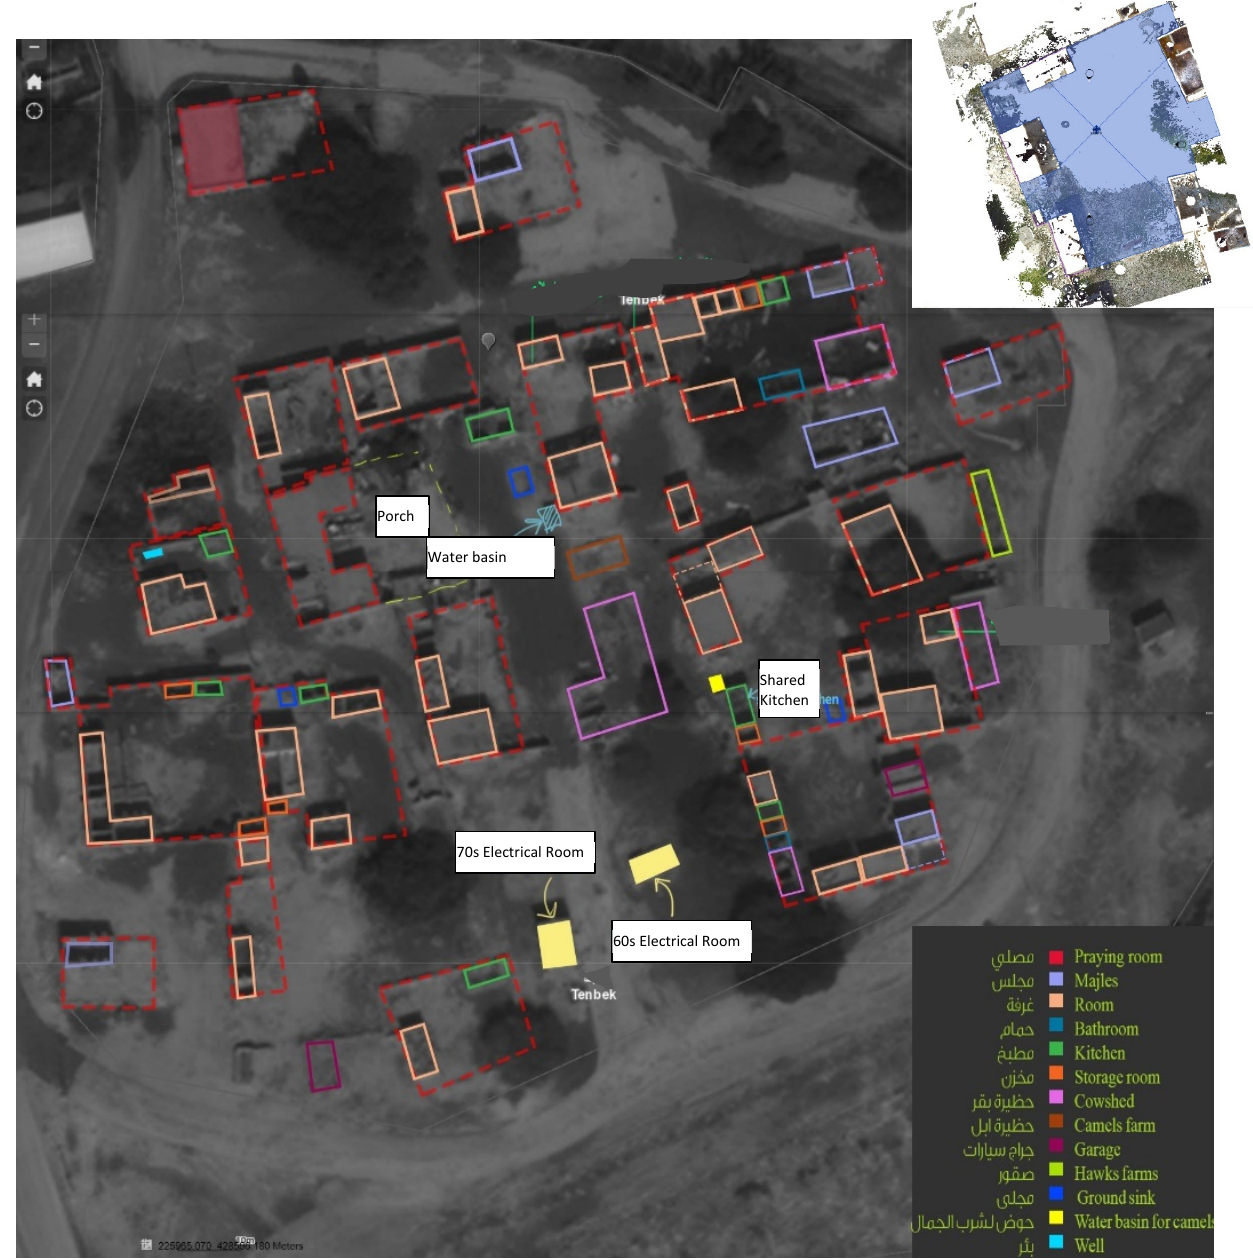
Figure 4. The 3D scanning of the existing structures of the village resulted in this master plan. It also shows an example of a 3D scanning for residential building 7 showing in blue the courtyard and the room in white. The house had an area size of 769 m 2